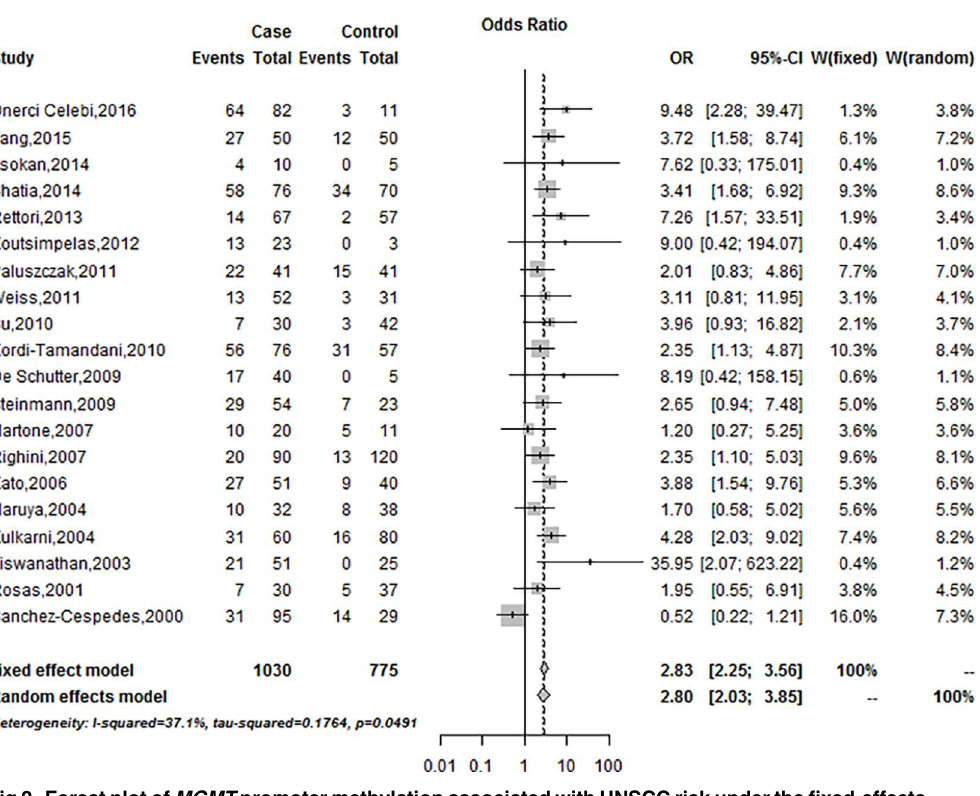
Fig 2. Forest plot of MGMT promoter methylation associated with HNSCC risk under the fixed-effects model.